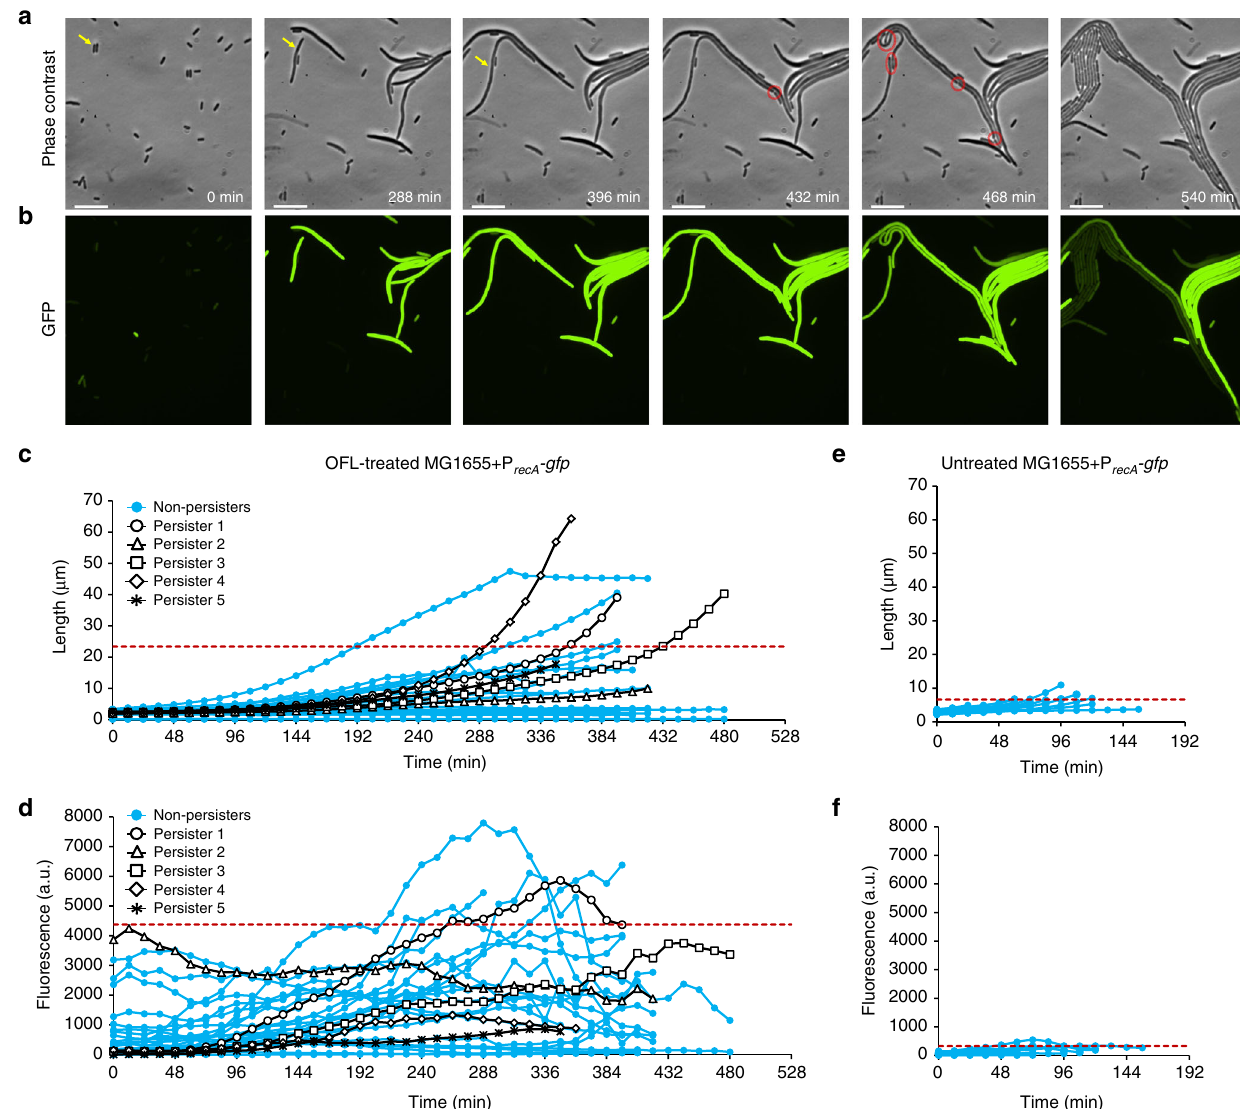
Fig. 1 Time-lapse microscopy with E. coli MG1655. a Representative phase contrast and b GFP fl uorescence images of recovering OFL-treated wild-type MG1655 E. coli bearing P recA -gfp . Yellow arrow indicates persister. Red circles indicate division events. The far-right panel shows the incipient colony formation from a persister. Images are representative of six biological replicates. c Growth and d fl uorescence of OFL-treated ( n = 30) and e , f untreated cells ( n = 20) recovering from treatment were analyzed. Of the 30 treated cells, fi ve were persisters (black data points) and 25 were non-persisters (blue markers). 95% of the cell length and fl uorescence measurements lie below the respective red dashed lines in c – f . The scale bars represent 10 μ m. Refer